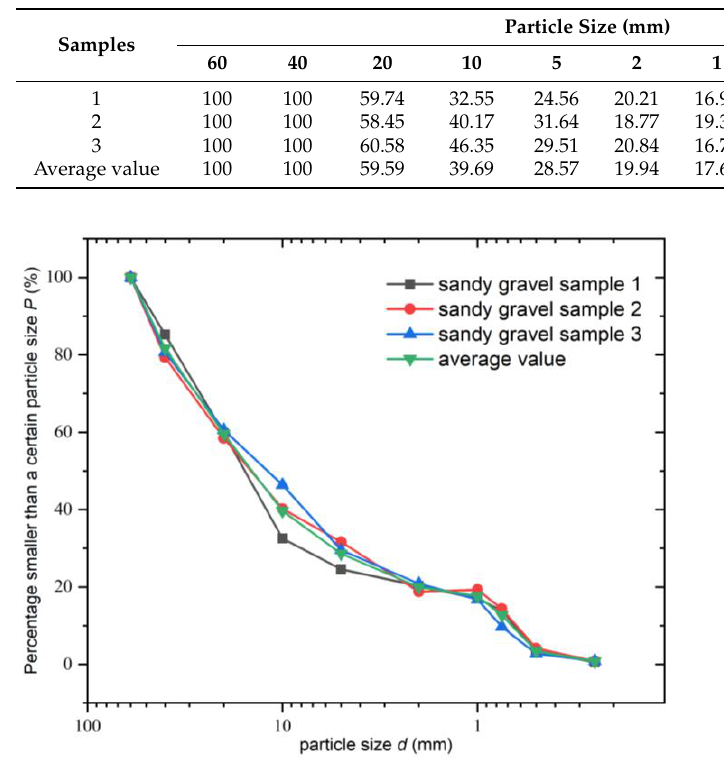
Table 2. Gradation of undisturbed sandy gravel (%).